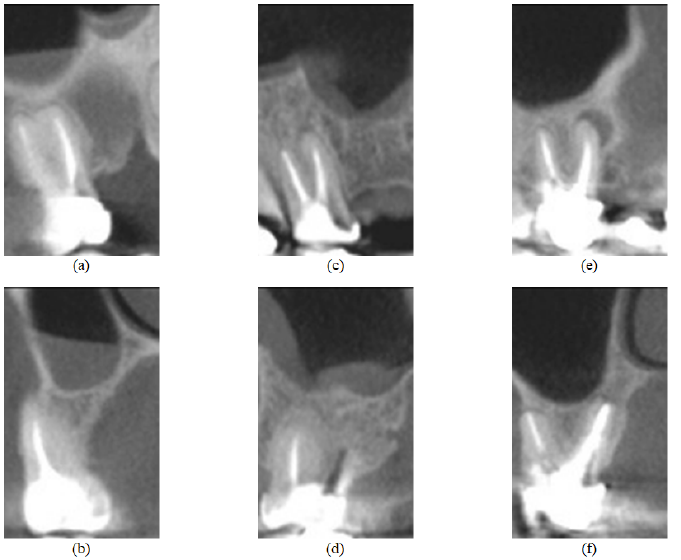
Figure 2. Feature images from the UFPE database, where ( a , b ) represent a tooth without lesion and are sagittal and coronal sections, respectively; ( c , d ) represent a tooth with small lesion and are sagittal and coronal sections, respectively; ( e , f ) represent a tooth with large lesion and are sagittal and coronal sections,